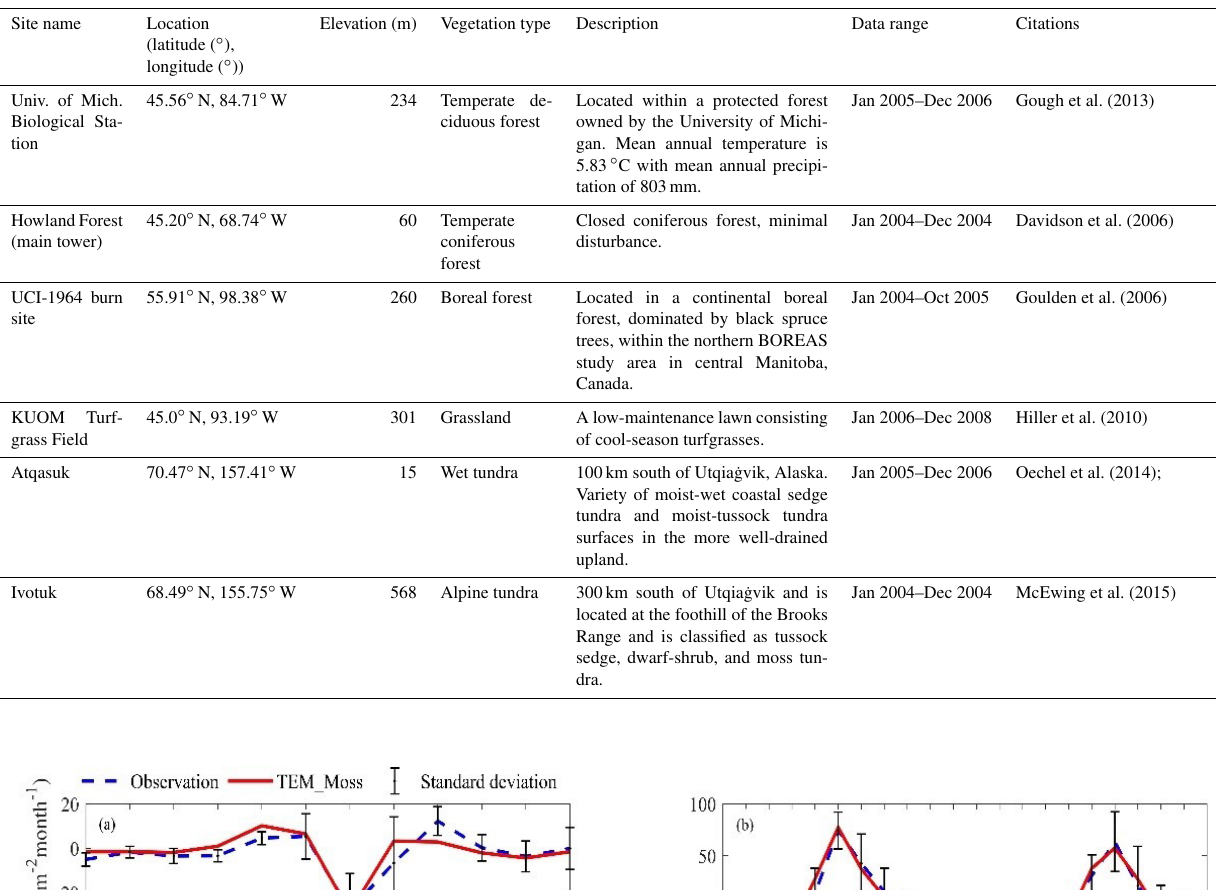
Table 2. Site description and measured NEP data used to calibrate TEM_Moss.